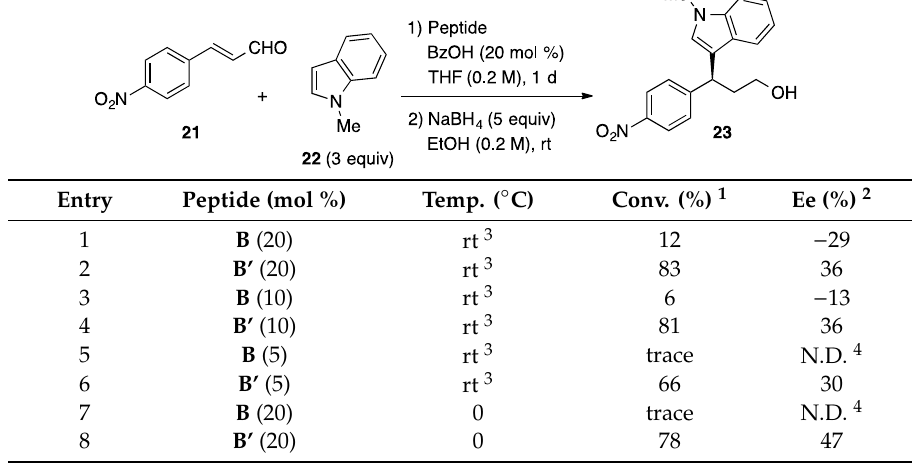
Table 2. Effect of the catalyst loading and temperature in the Michael addition reaction.